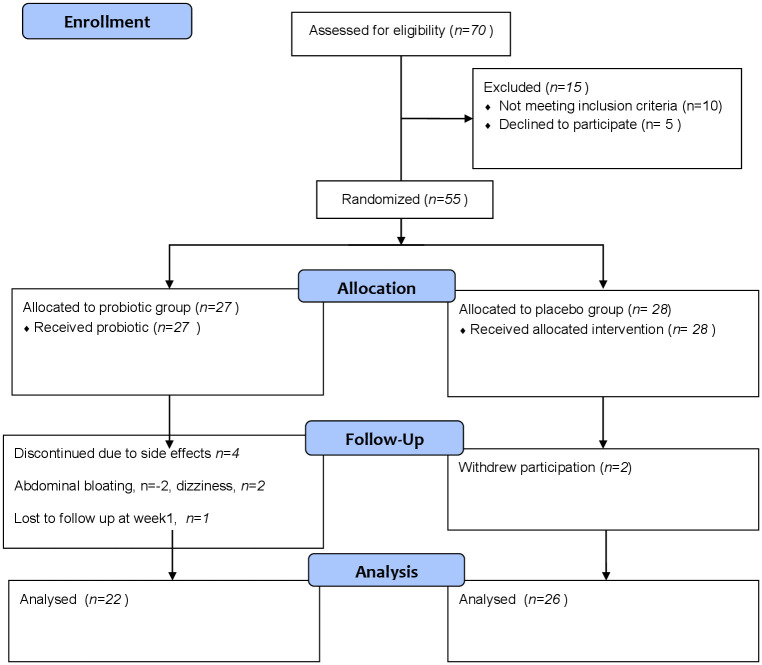
Study flow diagram.